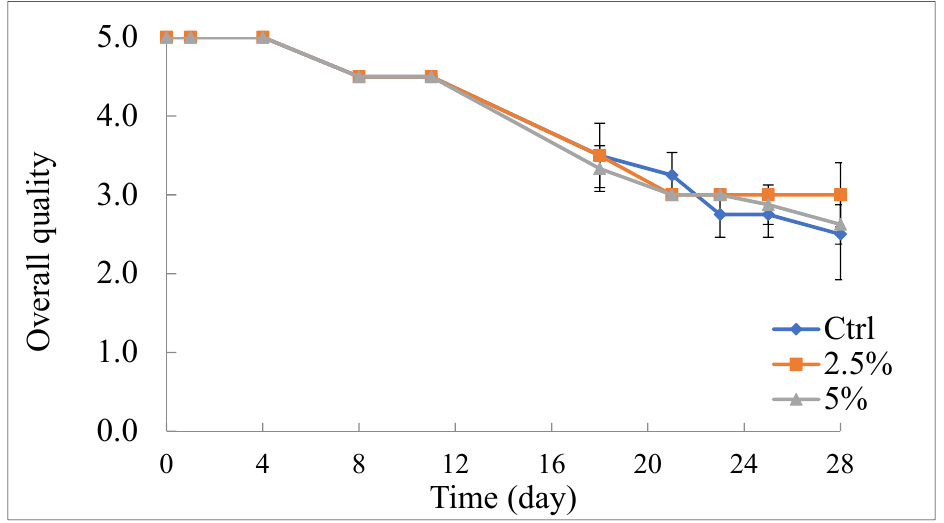
Figure 5. Overall quality of fruit salad during 28 days of refrigerated storage (5°C). Ctrl: fruit salad without pomegranate peel powder; 2.5%: fruit salad with 2.5% ( w / v ) pomegranate peel powder; 5%: fruit salad with 5% ( w / v ) pomegranate peel powder. Table 1. Sensory attributes of active and non-active fresh fruit salad during 28 days of storage at 5 °C. Storage Time (Days) Samples 0 Control Appear- ance